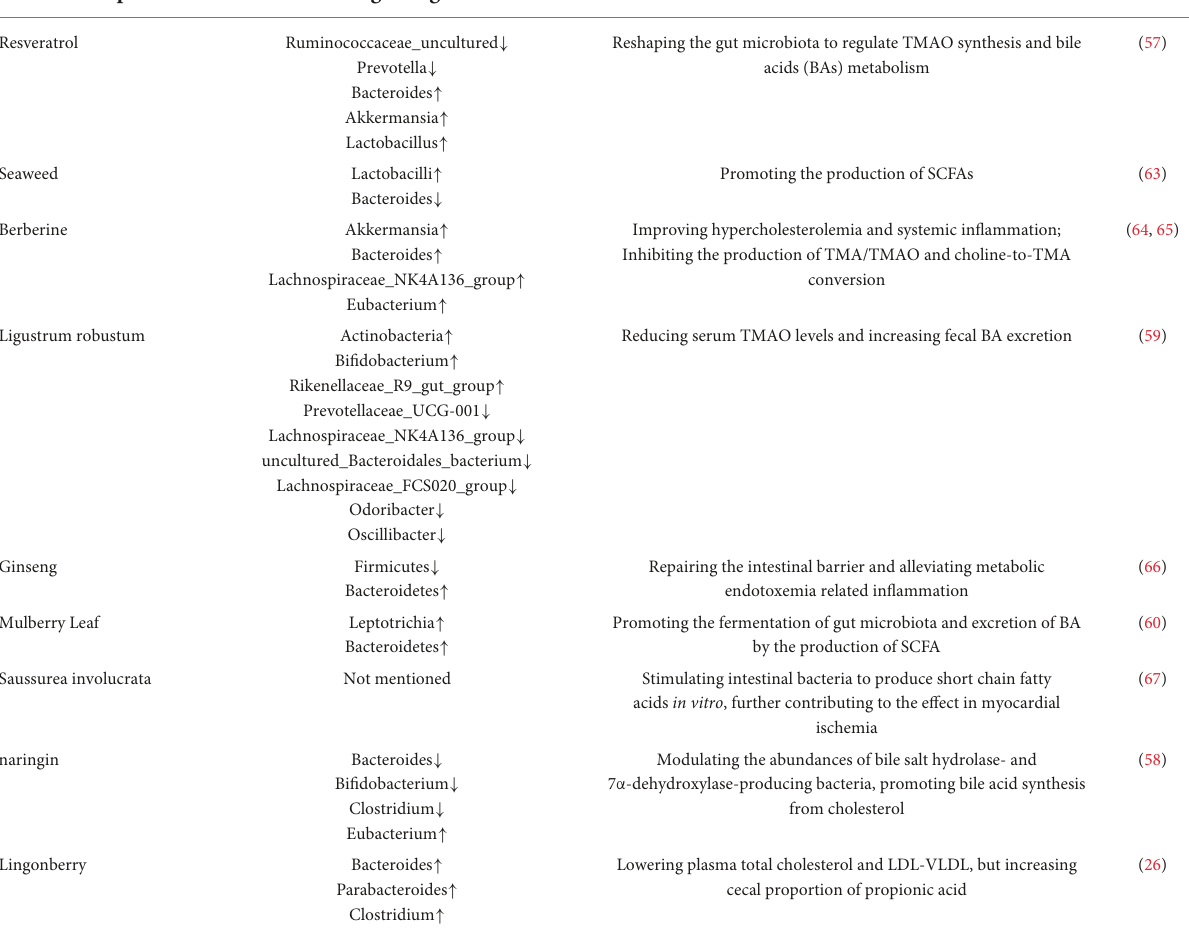
TABLE 7 Natural compounds intervening CHD through the regulation of gut